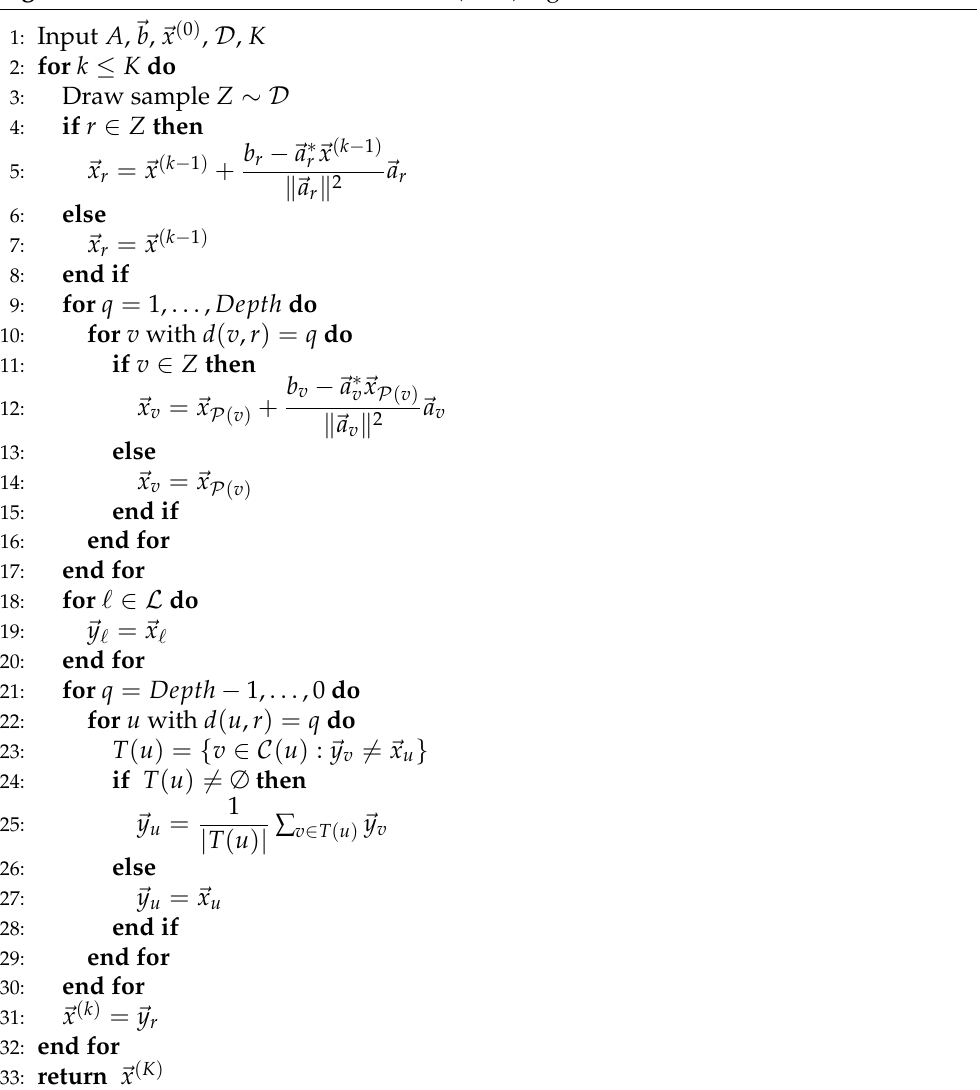
Algorithm 1 Randomized Tree Kaczmarz (RTK) algorithm.